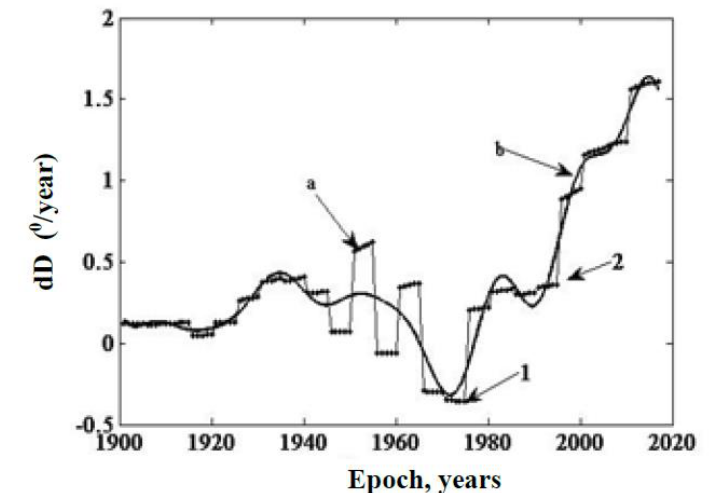
Fig. 2. Graphs: а - changes from year to year of geomagnetic declination dD at a point with geodetic coordinates of 90° north latitude, 0° west longitude for the period 1900 - 2020; b - approximation of the trend of changes dD using the global